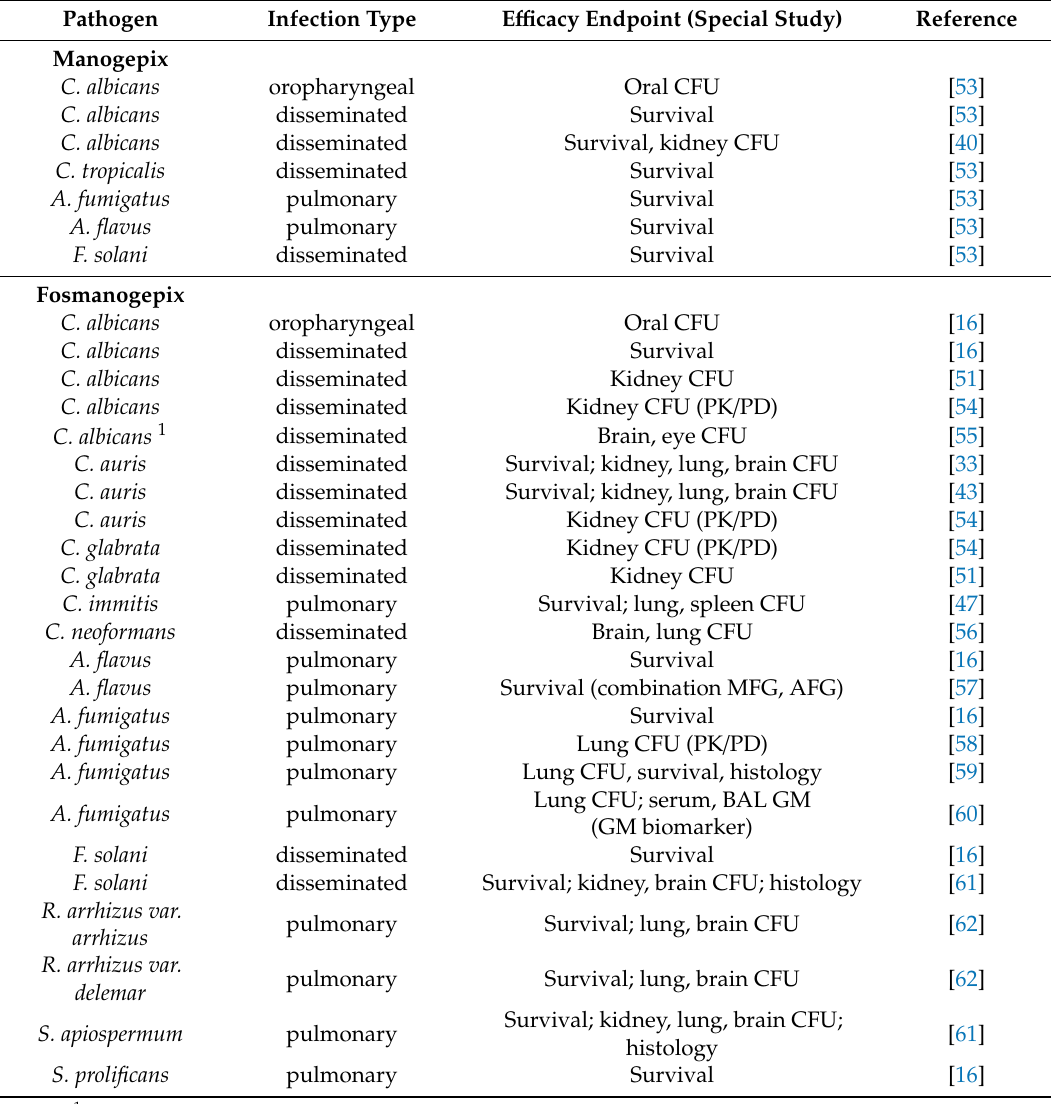
Table 4. Summary of animal e ffi cacy models for manogepix and